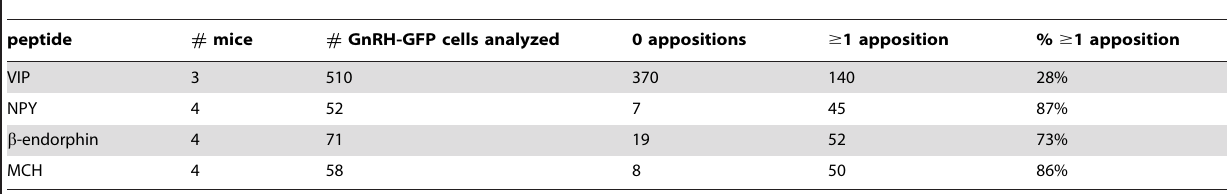
Table 1. Summary of peptidergic appositions on GnRH-GFP perikarya.